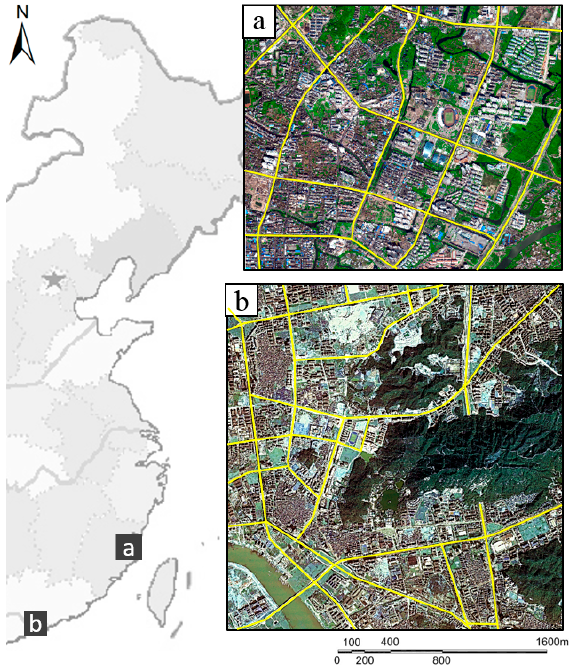
Figure 18. A comparison of two study areas in: ( a ) Putian; and ( b ) Zhuhai. The QuickBird images are shown in a band combination of 3/2/1 and main roads are outlined.